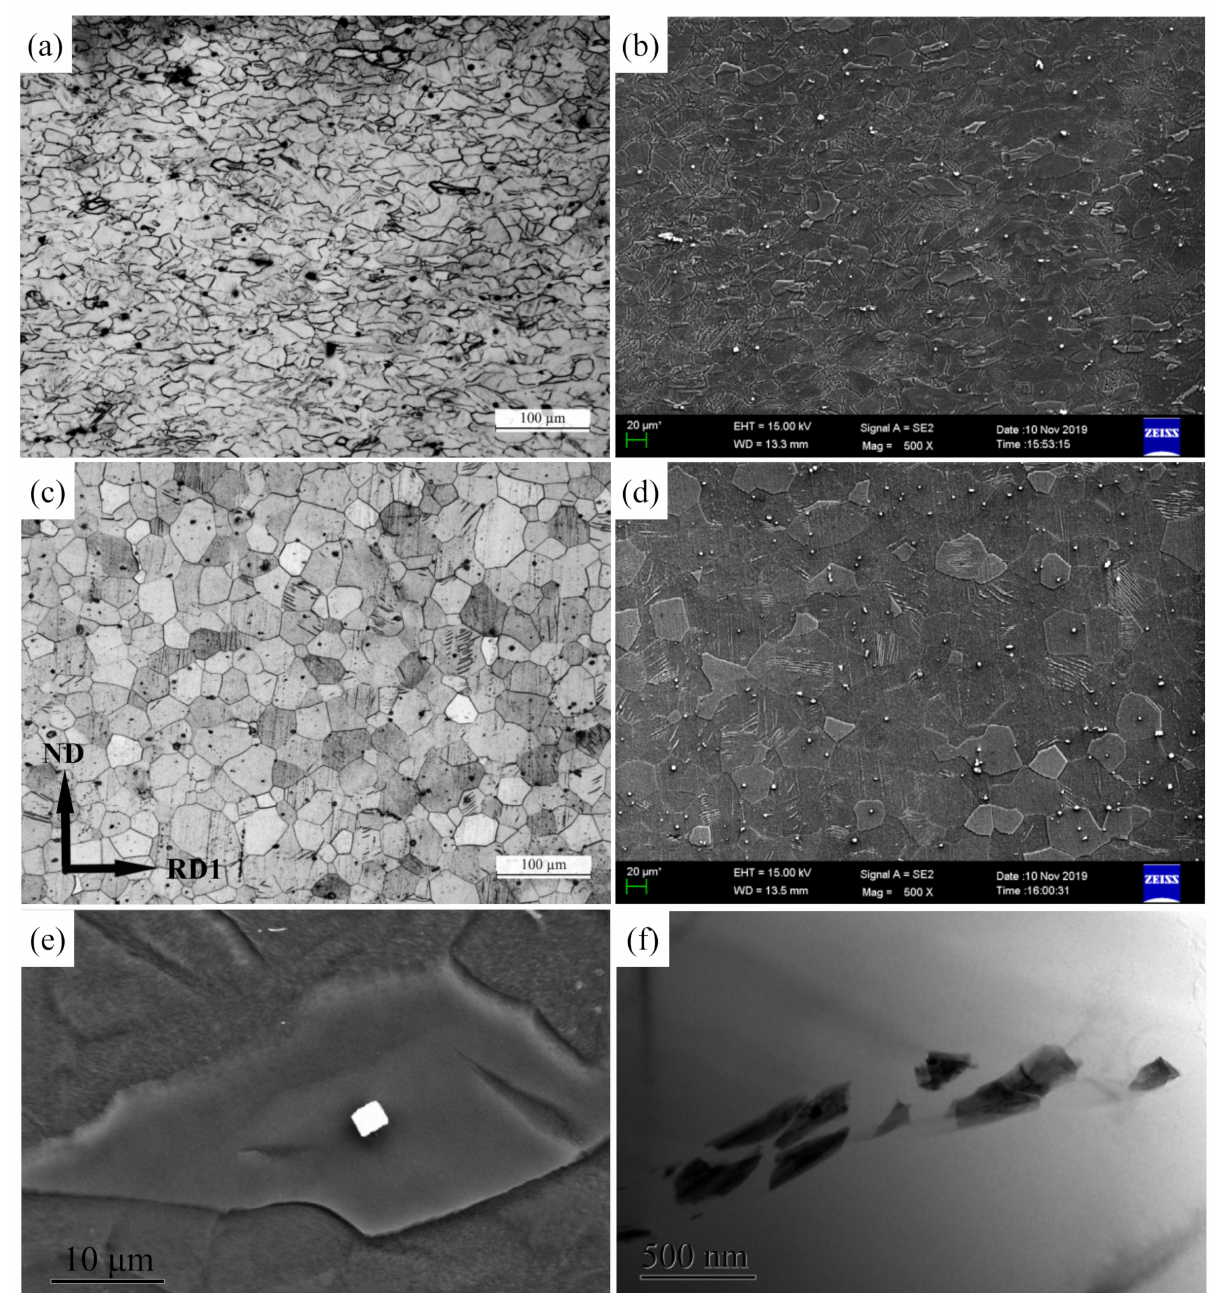
Figure 11. Optical micrographs of ( a ) as-rolled, ( c ) as-annealed, and corresponding SEM micrographs of ( b ) as-rolled and ( d ) as-annealed Mg-3Y sheets, the secondary phases; ( e ) SEM micrograph and ( f ) TEM micrograph of Mg-3Y